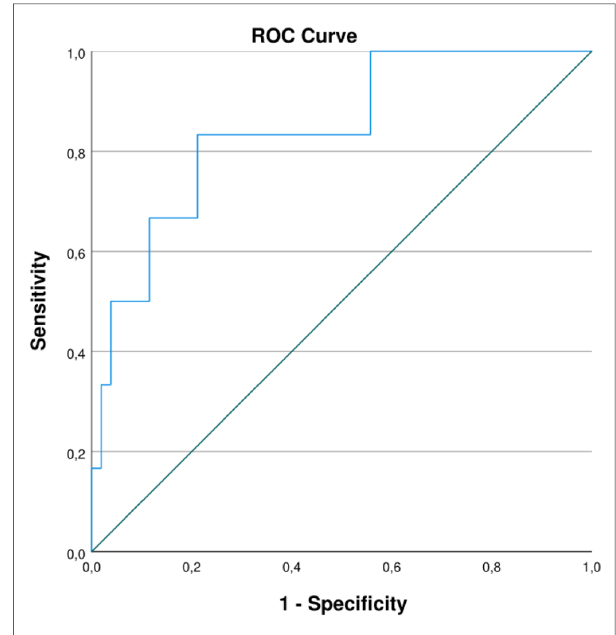
FIGURE 1 ROC curve of logistic prediction model for RT SpO2 by leak 1 . AUC of 84%. Sensitivity of 83.3% and speci fi city of 78.8% with a cutoff value of 42.16